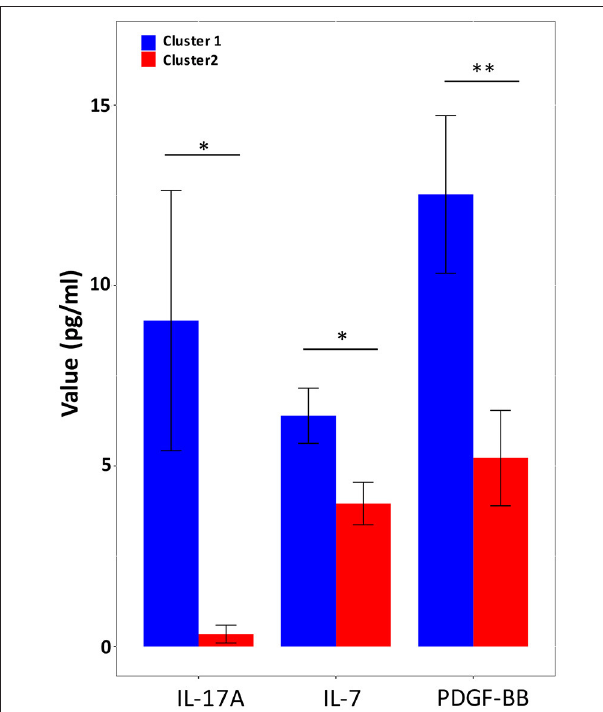
FIGURE 3 | Plasma cytokine levels with statistical difference between Cluster 1 and Cluster 2. Blue histograms, Cluster 1 ( n = 68); red histograms, Cluster 2 ( n = 10). Significance values are indicated: * p < 0.05 ** p < 0.01 based upon Mann-Whitney U -tests with Benjamini & Hochberg correction. FIGURE 4 | Correlation analysis of ascitic bacterial OTUs and plasma